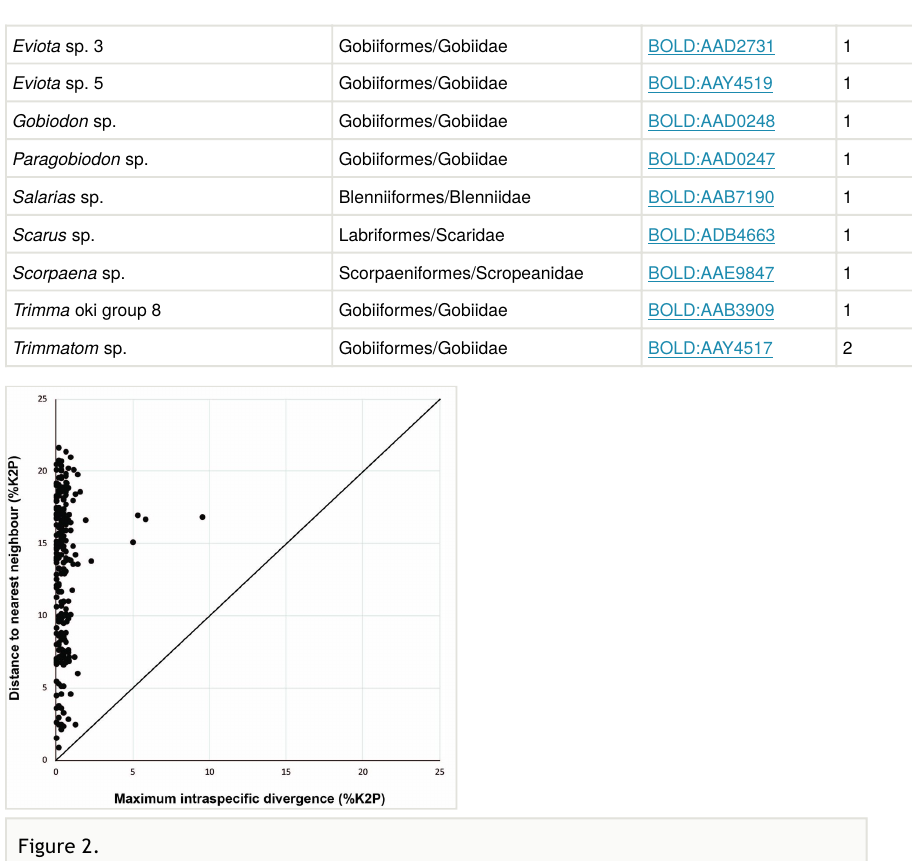
Figure 2. Plot of COI maximum intraspeci fi c divergence versus mean nearest-neighbour distance for 235 species of marine fi shes from Lizard Island represented by two or more individuals. Points above the diagonal line indicate species with a barcode gap.